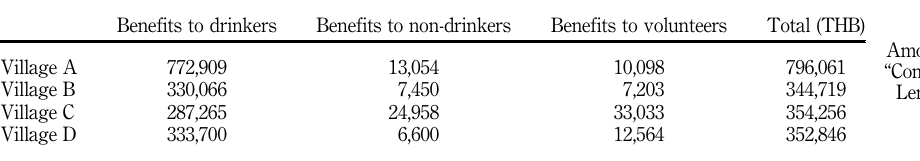
Table V. Amount of economic